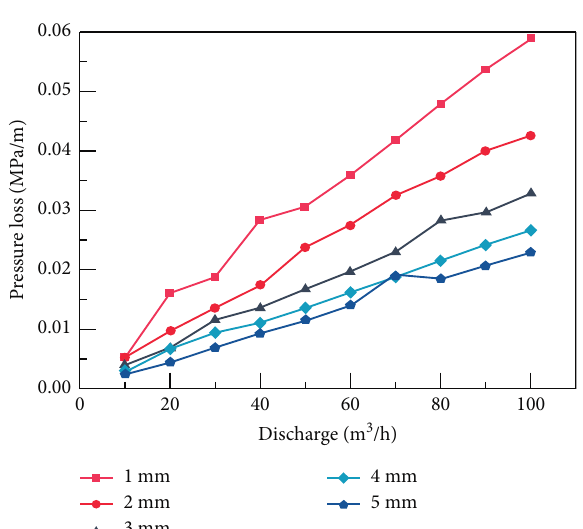
Figure 4: The pressure loss-discharge rate curve under different thickness of lubrication layer.